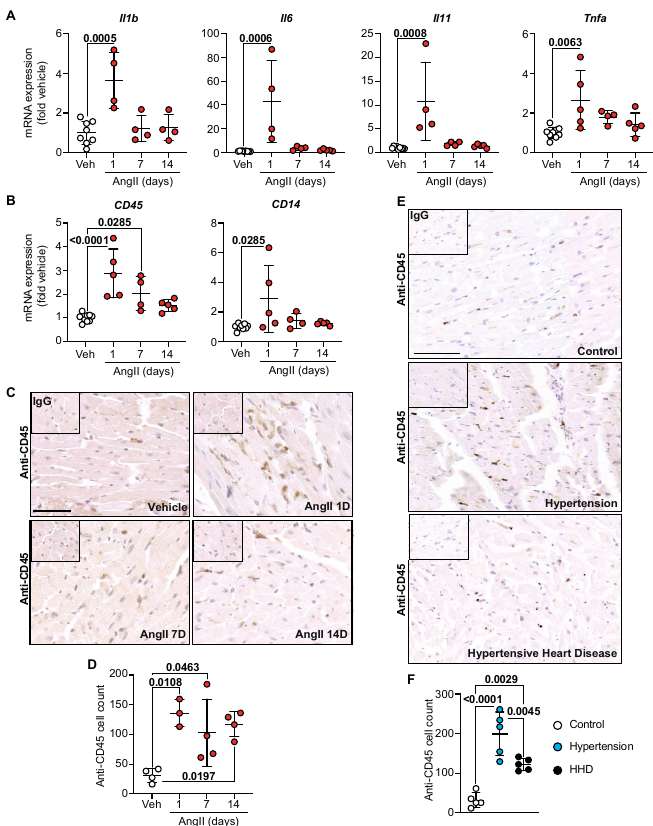
Figure 4. Inflammation initiates hypertensive cardiac remodelling . C57Bl/6J wild-type mice treated with Angiotensin II (AngII; 0.8 mg/kg/day) for up to 14 day. Cardiac RNA was isolated, and mRNA expression of pro-inflammatory cytokines ( A ) and general inflammatory cell markers ( B ) were determined by quantitative polymerase chain reaction. Data are individual points with means ±